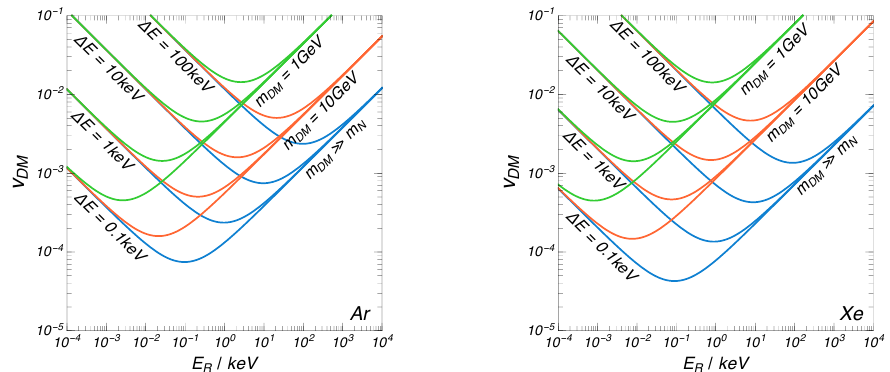
Figure 1 . The minimum dark matter velocity as a function of the atomic recoil energy E R for given (cid:1)E and m DM for Ar and Xe.